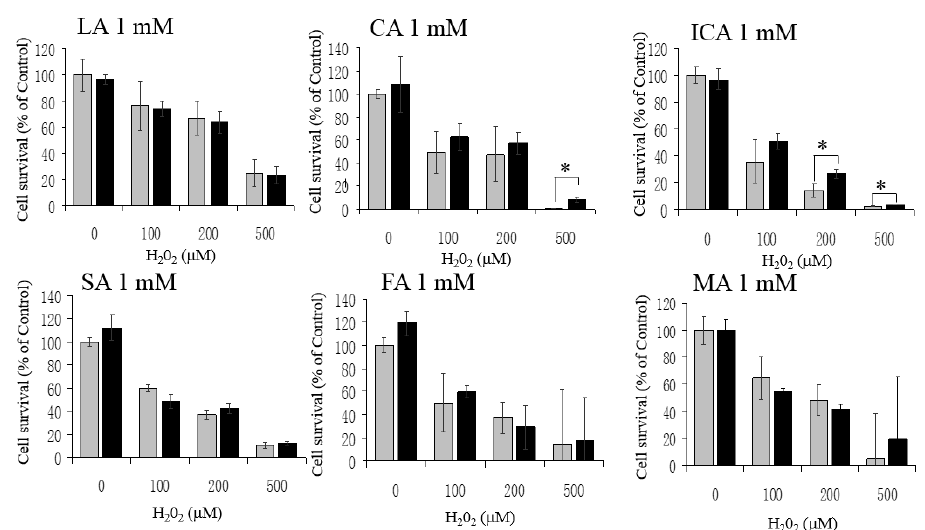
Figure 4. No protection of HT22 cells against H 2 O 2 by the other KCIs at 1 mM. Neither LA, CA, ICA, SA, FA, nor MA protected the cells against H 2 O 2 -mediated cytotoxicity. White bars are H 2 O 2 alone; and gray bars are H 2 O 2 + KCI. Values, presented as a percentage of the control MTT value (obtained in the absence of glutamate), are given as the mean ± SD ( n = 4). * significantly different ( p < 0.05) from samples without a KCI. Antioxidants 2017 , 6 , 21